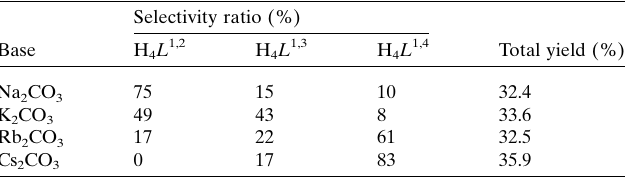
Table 1 Base-dependent synthesis of three regioisomers of singly bridged calix[6]crown-6. Reaction conditions: calix[6]arene (1.0 equiv), base (2.0 equiv), pentaethylene glycol ditosylate (0.9 equiv), xylene (500 ml), reflux. Selectivity ratios were determined by 1 H